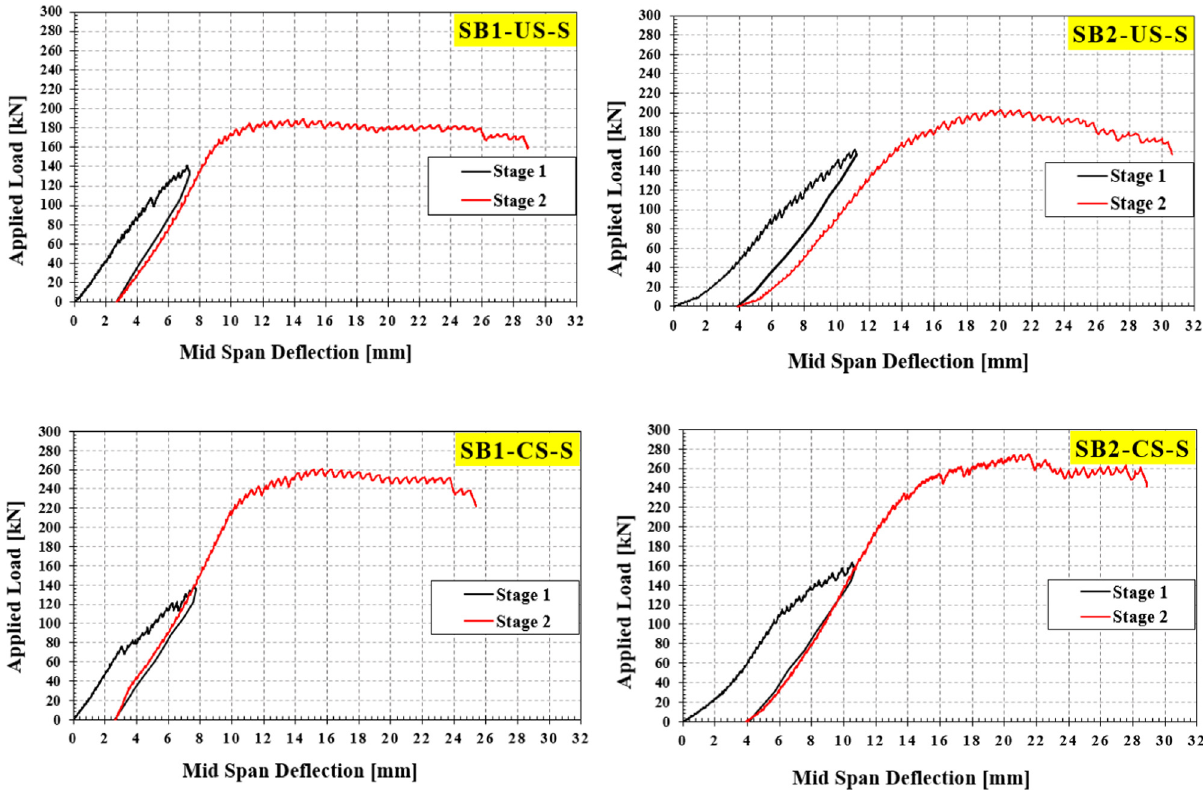
Figure 10: Load – vertical de fl ection curve at mid - span section for tested spandrel beams.